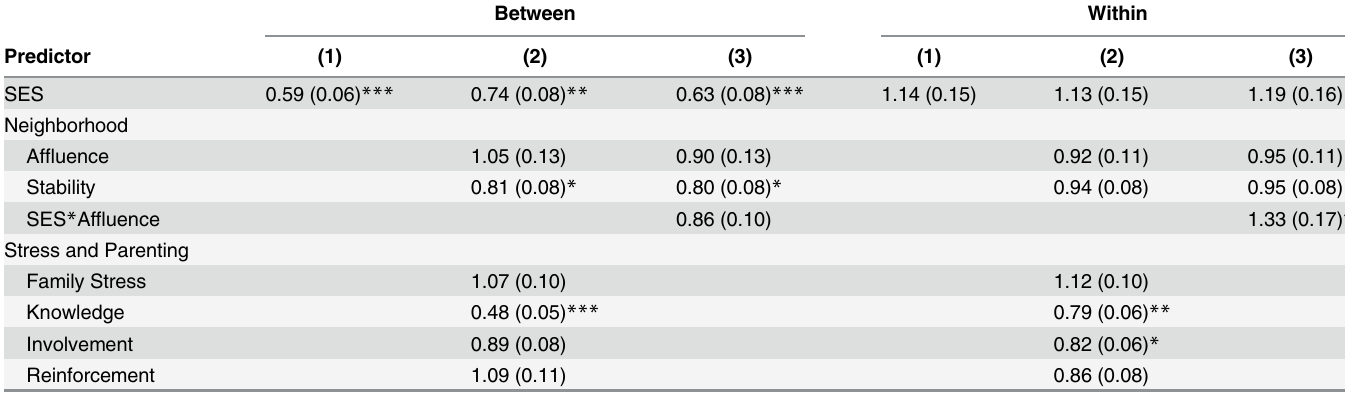
Table 3. Regression Models for Minor Delinquency. Note . Odds ratios with standard errors in parentheses. Control variables omitted from table: single caretaker, ethnicity, and age dummies.